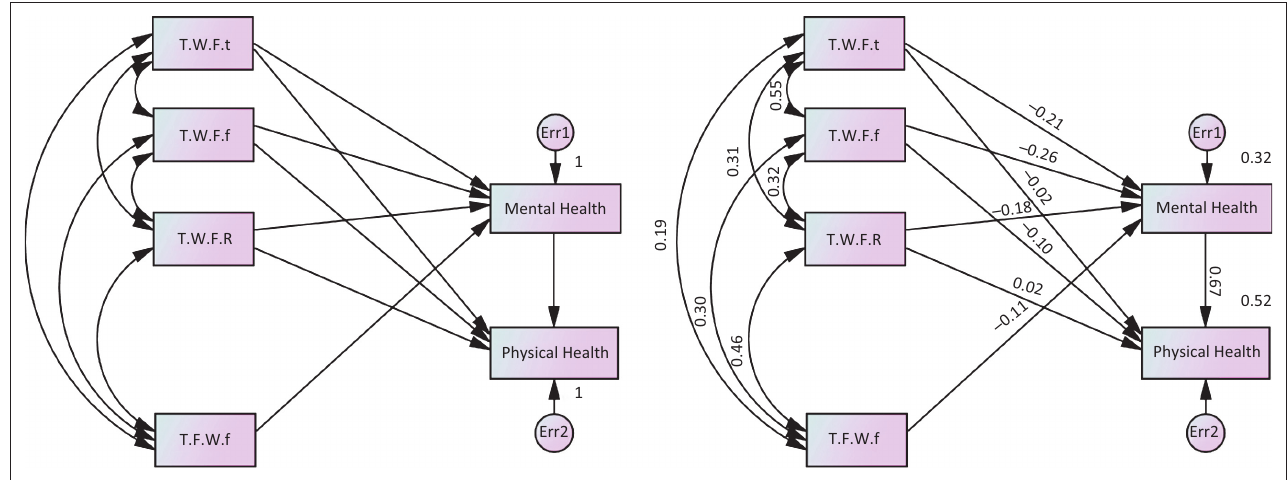
FIGURE 3: Revised model of the relationship between the research